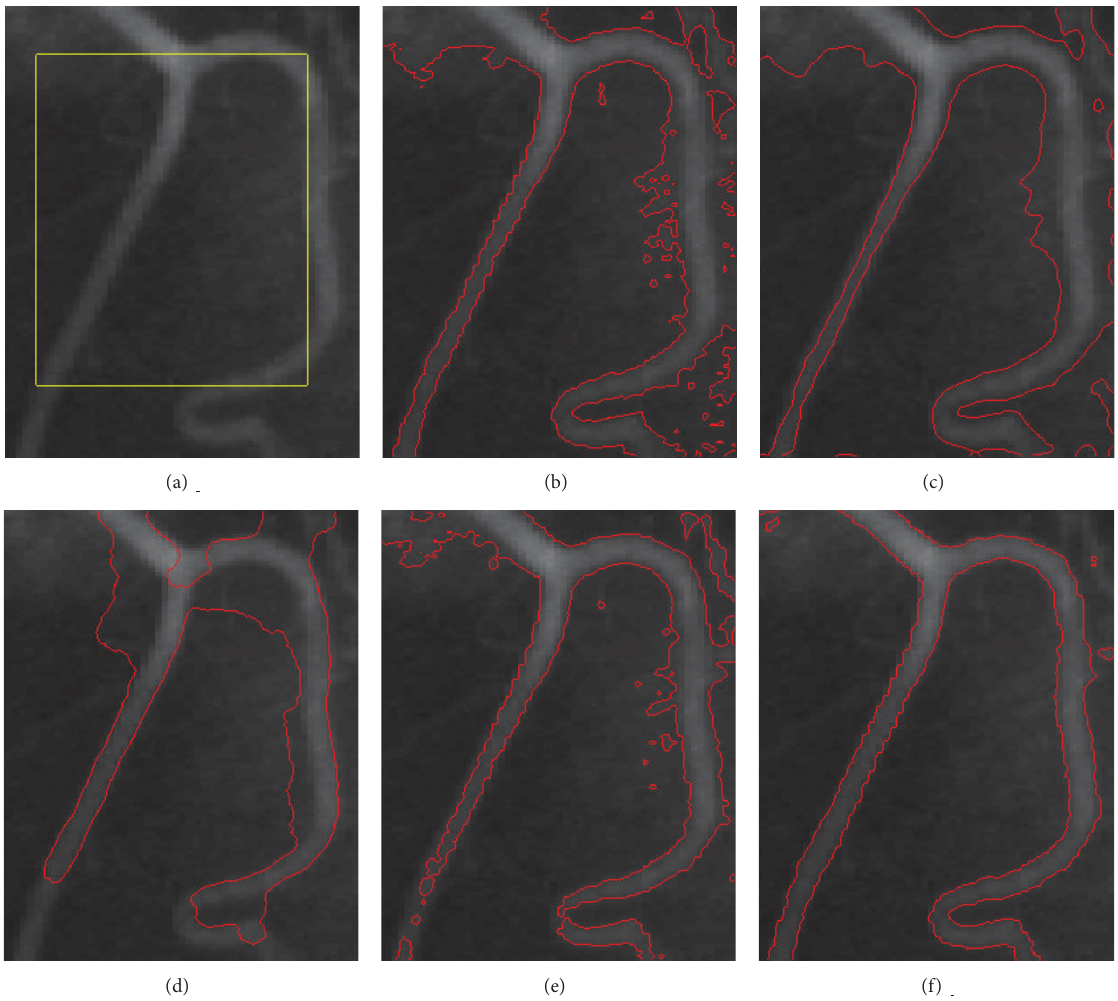
Figure 16: Segmentation results on the second vessel image: (a) the initial contour, (b) the CV model result, (c) the GACV model result, (d) the DRLSE model result, (e) the FAC model result, and (f) the LFAC model